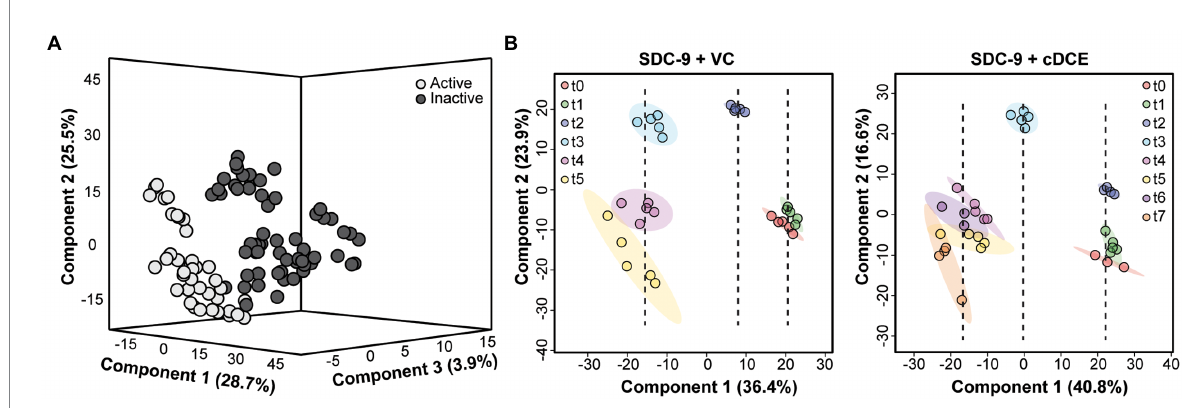
FIGURE 2 Multivariate analyses of samples classified by dechlorination status or time point. (A) 3D PLSDA showing separation between samples classified by dechlorinating activity (Active or Inactive) but not classified by time; (B) PLSDA showing separation between samples classified by time point, but not dechlorinating activity, for cultures grown with either VC or